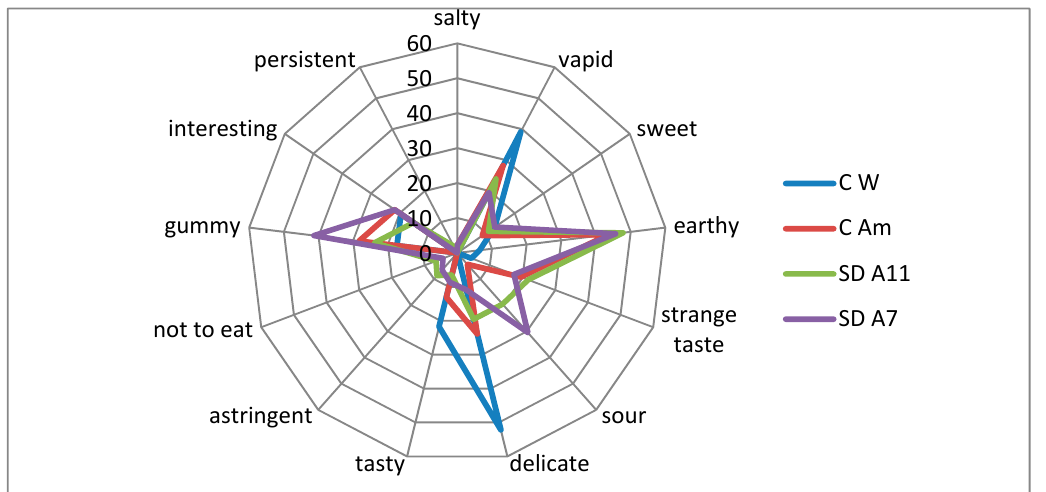
Figure 5. Spider plot of the sensory evaluation (%) of breads. Blue line: % of positive answers given to wheat control bread (C W); red line: % of positive answers given to amaranth control bread (C Am); green line: % of positive answers given to L. farciminis A11 sourdough bread (SD-A11); purple line: % of positive answers given to L. brevis A7 sourdough bread (SD-A7).